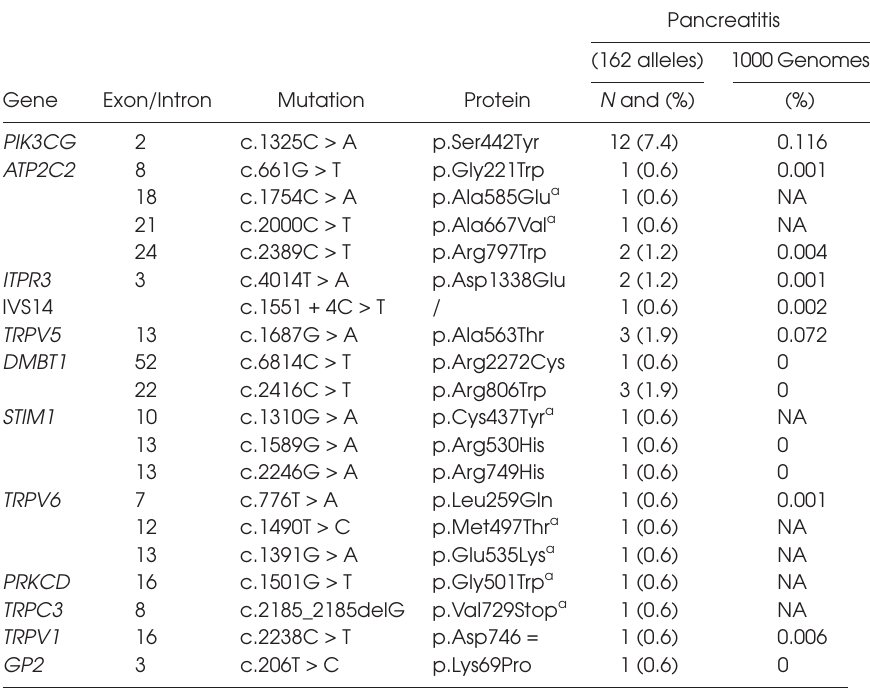
Table 2. Mutation frequency in genes encoding proteins involved in calcium signaling pathways and zymogen granules